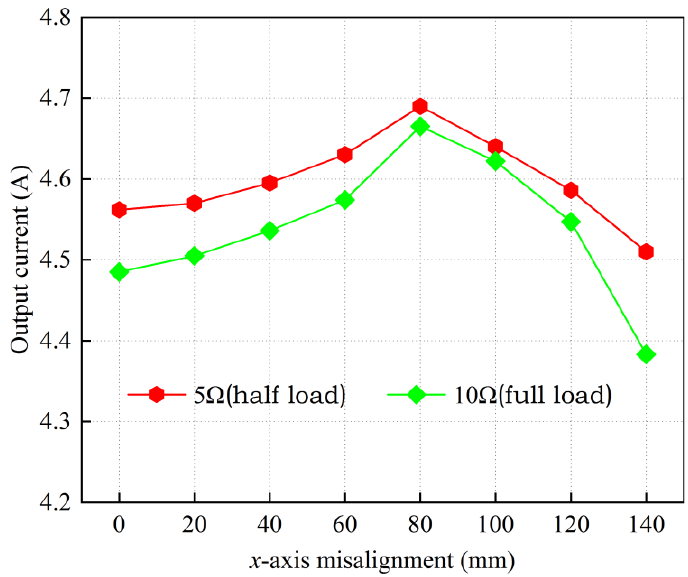
Figure 10. Measured output current with different load and misalignment.